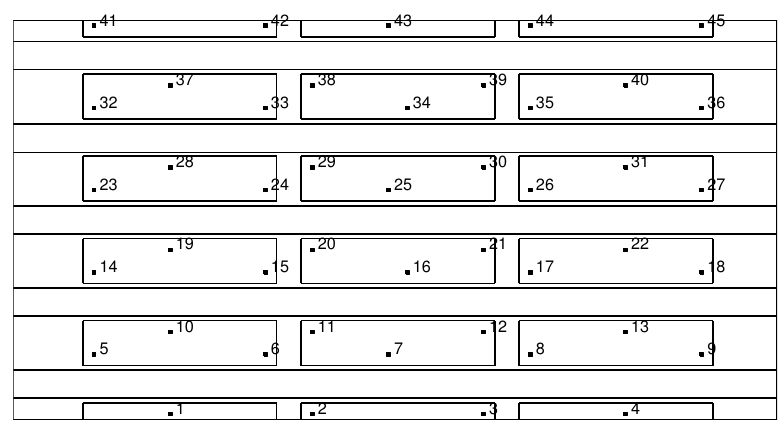
Figure 7. Stiffened panel with forty-five possible sensor locations.